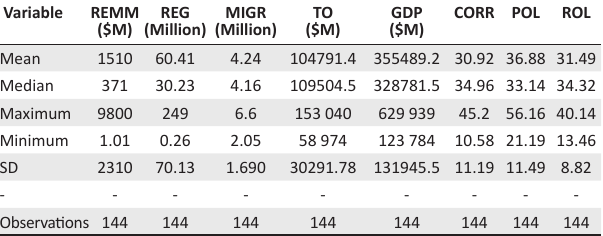
TABLE 2: Descriptive statistics of